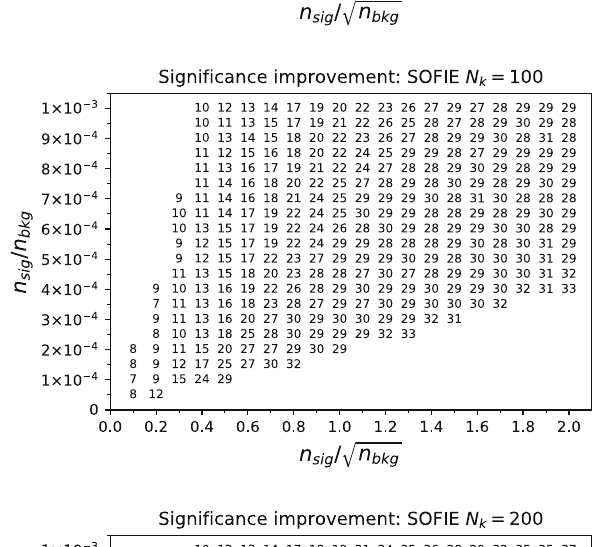
Fig. 12 Expected significance of the deviations per 100 GeV bin at three stages: a in the untagged event sample; b using only the MUST jet tagging; c using the full SOFIE anomaly detection method. In-situ mass decorrelation is used with ε b = 0 . 01